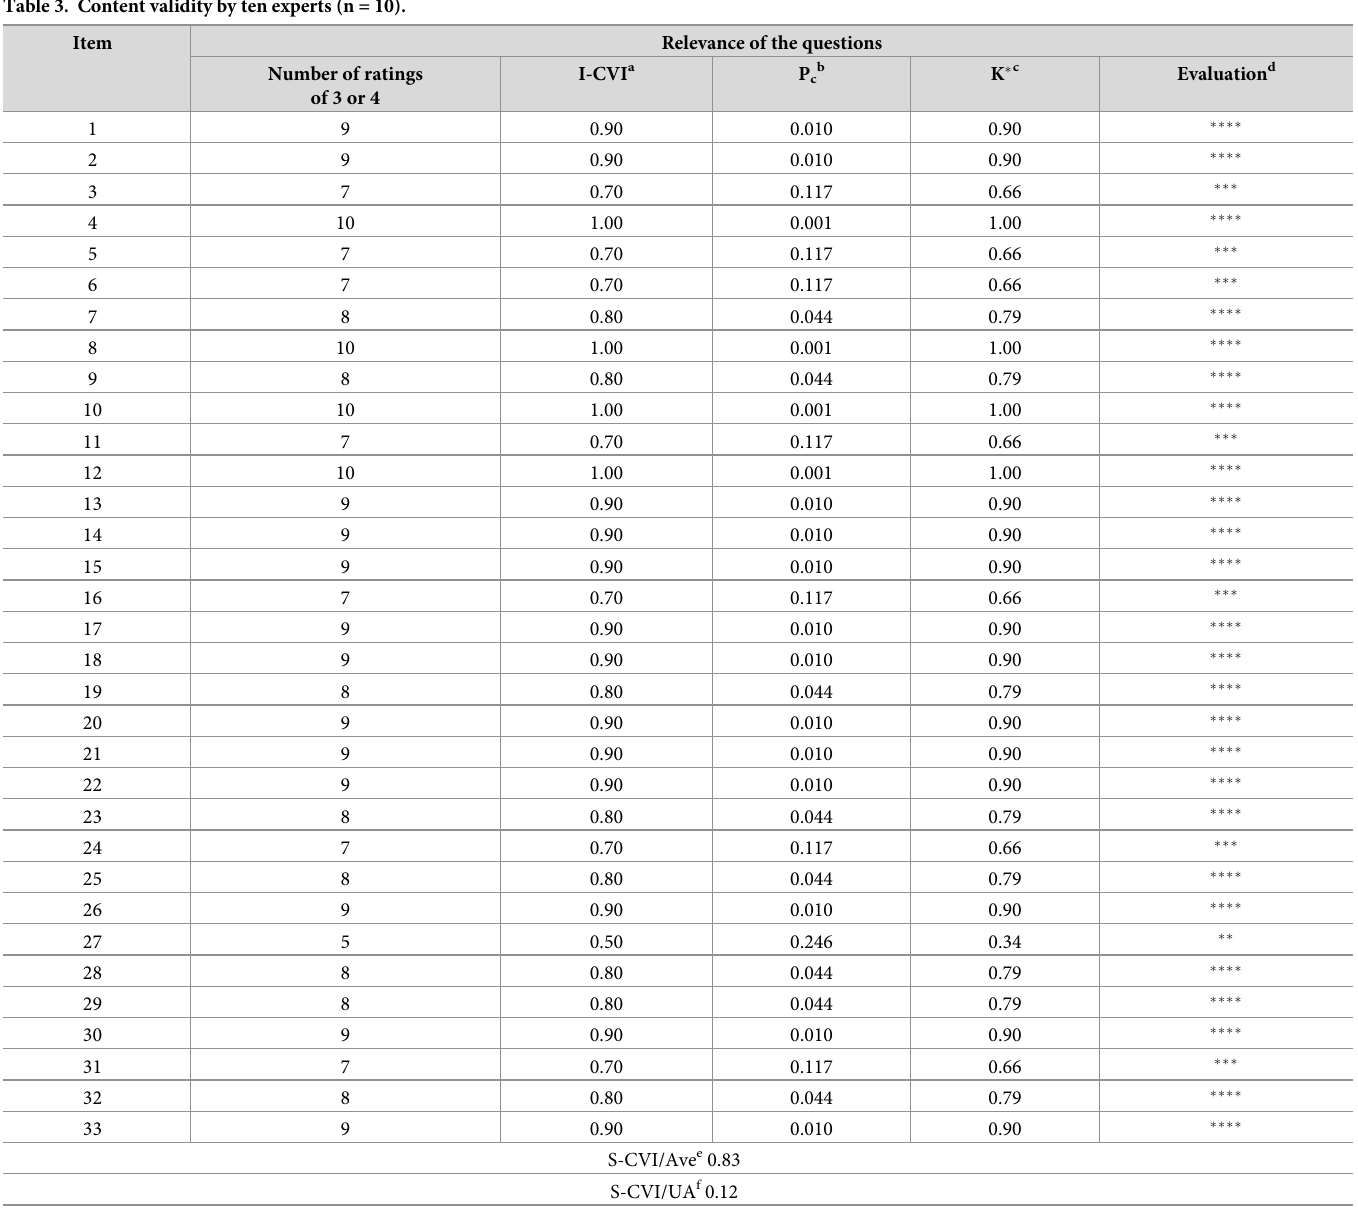
Table 3. Content validity by ten experts (n =